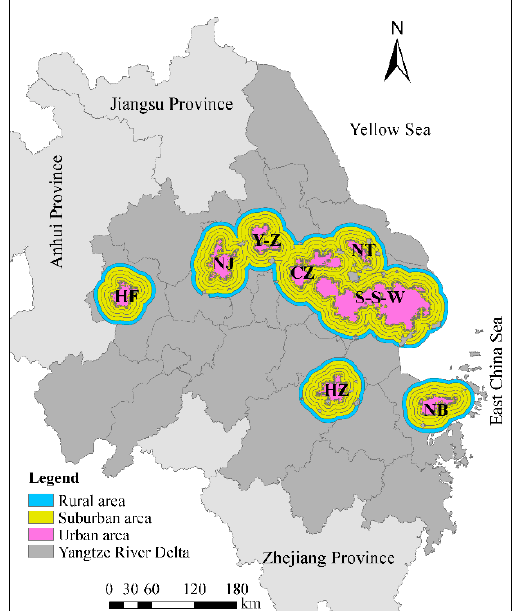
Figure 5. Location of the eight most developed urban areas in the Yangtze River Delta, an example from 2015. The eight most developed urban areas are Changzhou (CZ), Hefei (HF), Hangzhou (HZ), Nanjing (NJ), Nantong (NT), Ningbo (NB), Shanghai-Suzhou-Wuxi (S-S-W) and Yangzhou-Zhenjiang